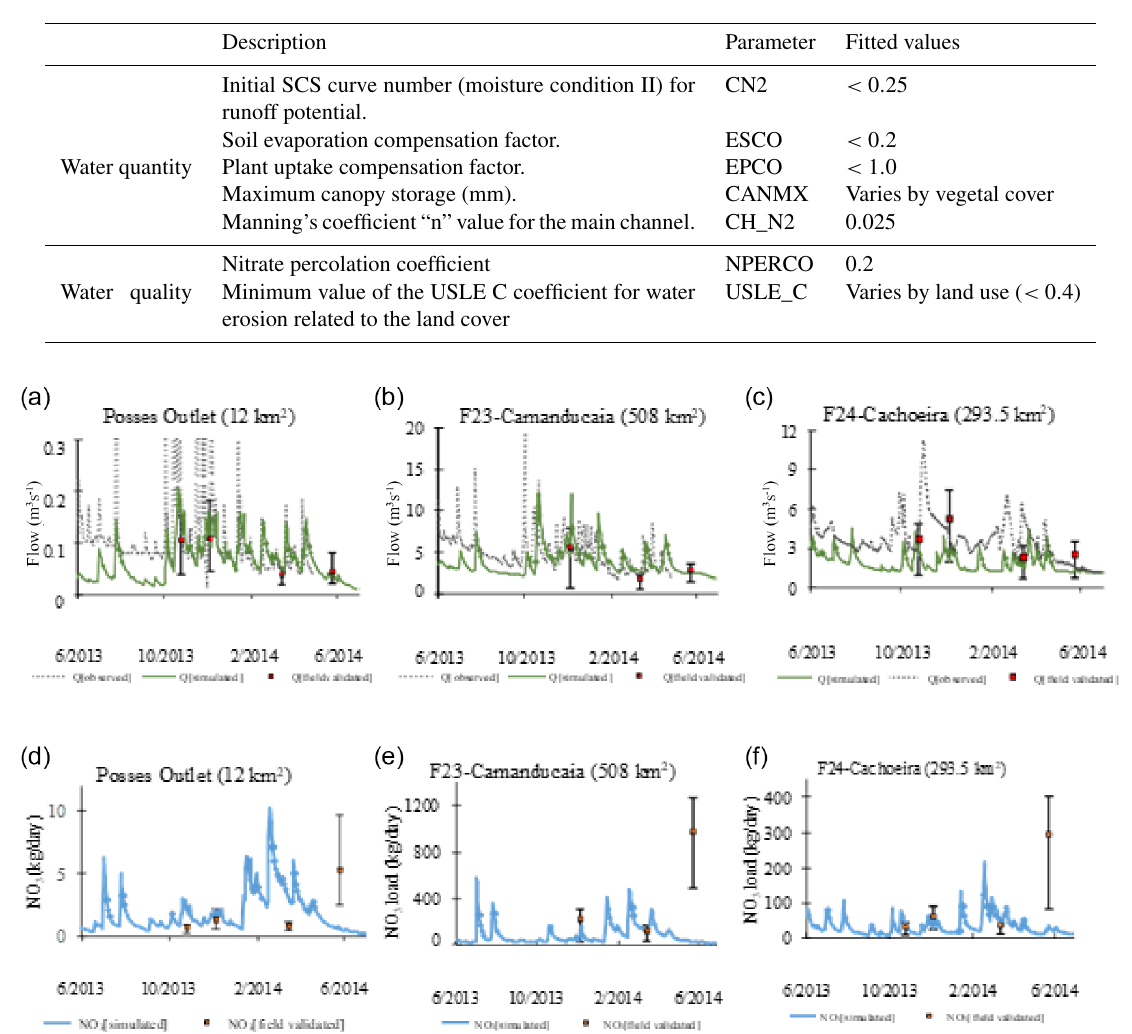
Figure 5. Comparison between flow discharges (upper part) and nitrate loads (lower part), through observed flows (dotted lines), simulated by SWAT (solid lines) and field validation through instantaneous experimental samples (marked points with uncertainty intervals) at monitored stations of Posses outlet (left part), F23 Camanducaia (center part) and F24 Cachoeira (right part). The uncertainty bars were determined using instantaneous velocities measured in the river cross-sections during 2013/14 field campaigns (Taffarello et al., 2016a). The uncertainty bars represent the minimum and maximum values of measured streamflow and pollutant loads in a cross section of the river during a field campaign of headwater